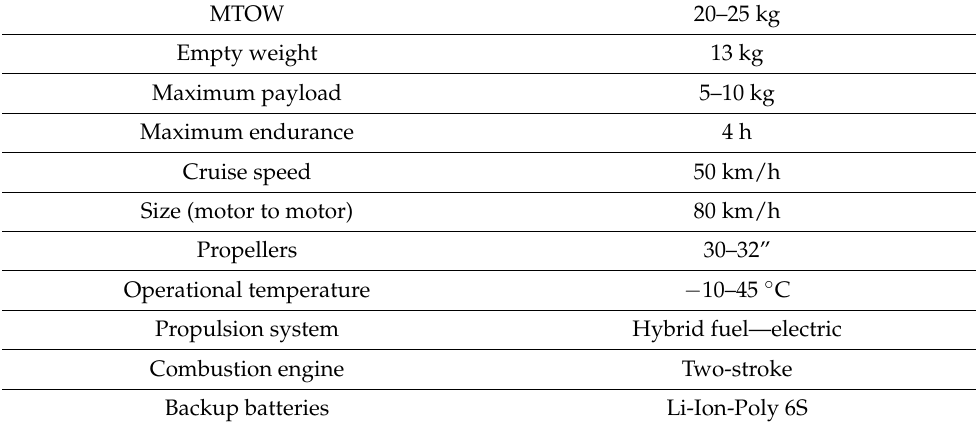
Table 1. Quaternium-HYBRIX™